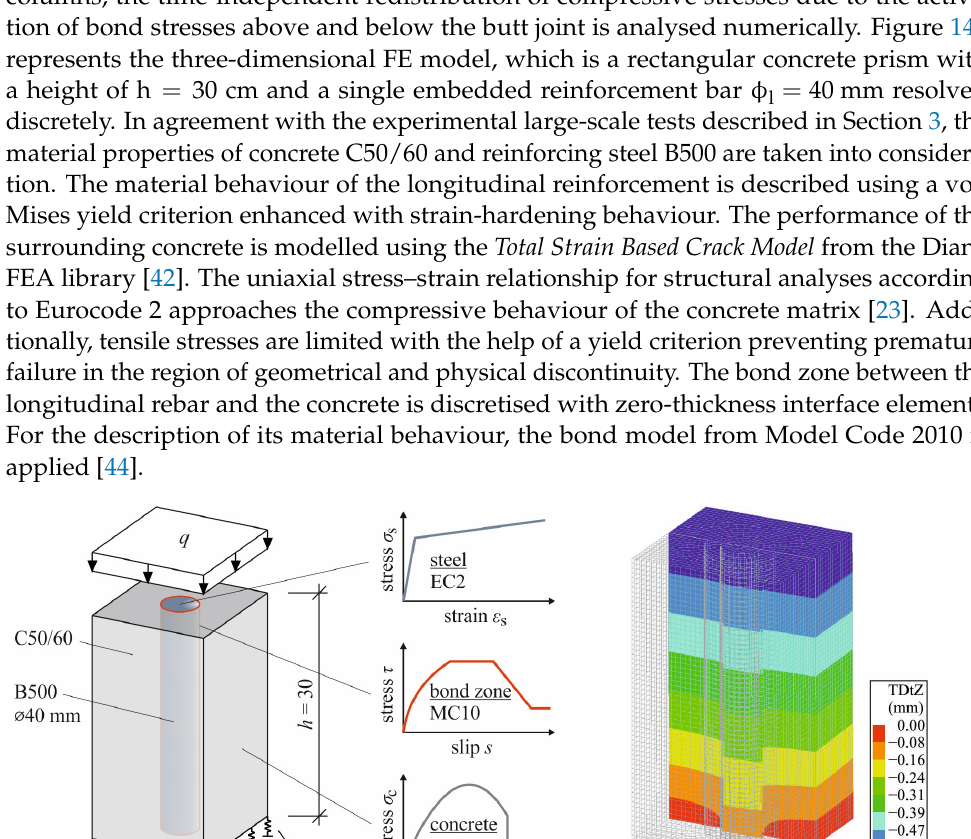
( b ) Figure 15. Evaluation of stresses: ( a ) bond stresses in the interface; ( b ) development of concrete and steel stresses over the height. Further numerical simulations with a varying spring stiffness provide different maximum slip values representing the indentation of the longitudinal rebar into the support layer. Figure 16 (left) summarises the resulting indentation s relative to the applied spring stiffness k. The indentation decreases with increasing stiffness of the spring support, which is equivalent to the resilience of the butt joint. The diagram further indicates that with application of the bond model for good bond conditions from the MC